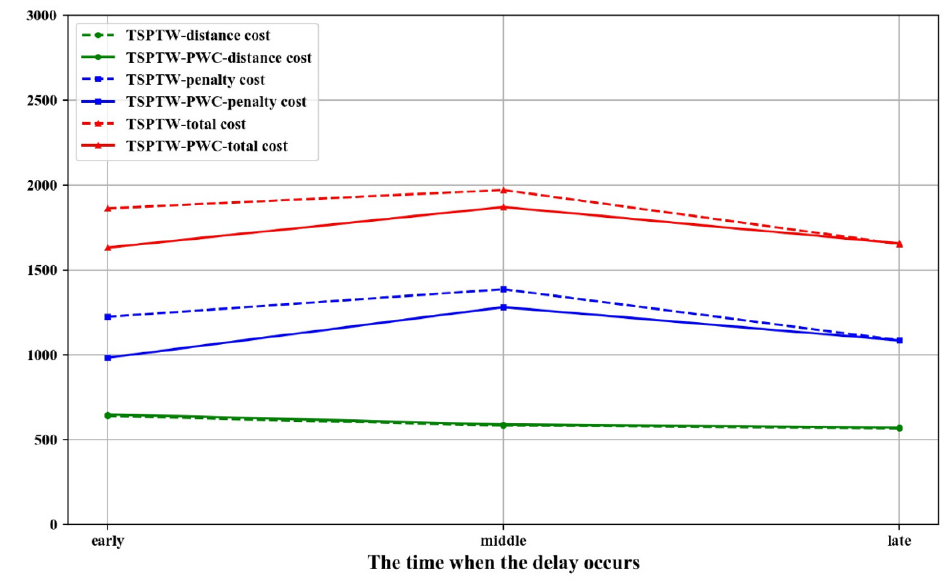
Figure 5. Cost comparison for different delay occurring time.